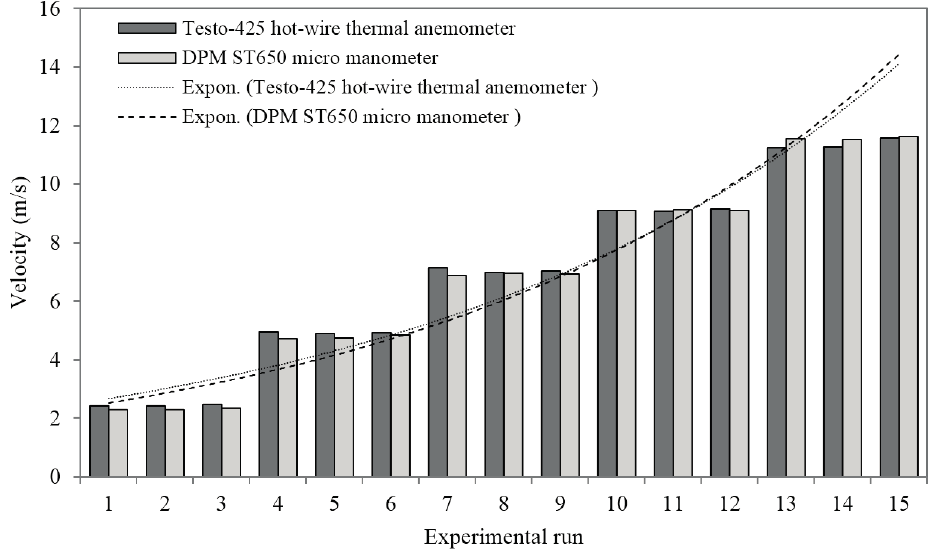
Figure 13. Comparison of velocity measurements using the Testo-425 hot-wire thermal anemometer and DPM ST650 micro